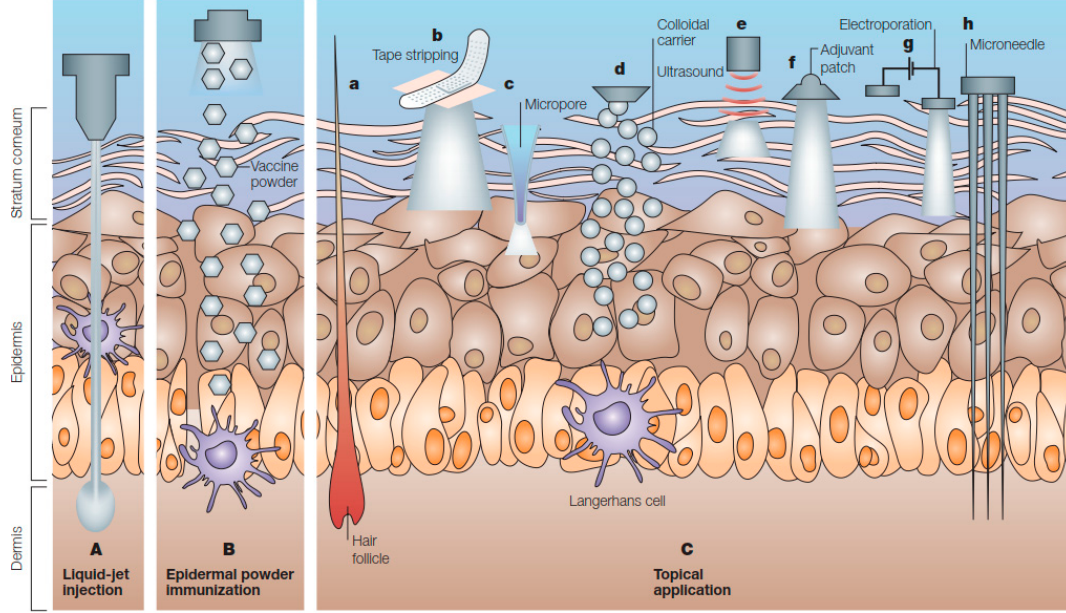
Figure 1. Immunization by cutaneous routes. A. Liquid-jet injection delivers vaccine to muscular, subcutaneous or dermal regions, depending on the parameters of the injection, B. Epidermal powder immunization delivers vaccine powders to the superficial layers of the skin, C. Topical application of vaccines delivers vaccines to the epidermis, where they are recognized and processed by Langerhans cells. Immunization by topical vaccine application is facilitated by several methods (a–h) (Reprinted with permission from Ref. [1]).